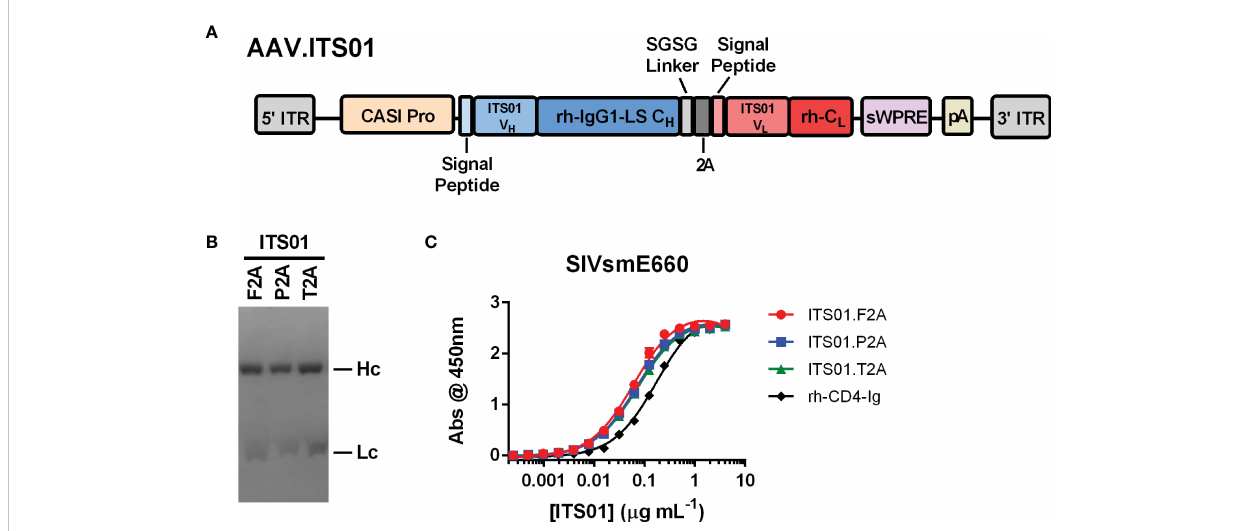
FIGURE 1 Schematic and characterization of ITS01 expressed from an AAV transfer plasmid. (A) Schematic of an the AAV vector encoding ITS01 from 5 ’ ITR to 3 ’ ITR. ITS01 expression is driven by a CASI promoter and utilizes a 2A peptide to generate both the heavy and light chains. (B) Coomassie-stained SDS-PAGE of puri fi ed ITS01 antibodies generated with the indicated 2A peptide. (C) SIVsmE660-coated ELISA plates were incubated with indicated concentrations of puri fi ed recombinant ITS01 antibody. ITS01 binding was determined using an HRP-conjugated, anti-human Fc secondary antibody and binding activity was measured at an absorbance of 450 nm. ITS01 antibody made using F2A, P2A, and T2A peptide is indicated. rh-CD4-Ig is a positive control protein. Error bars indicate standard deviation